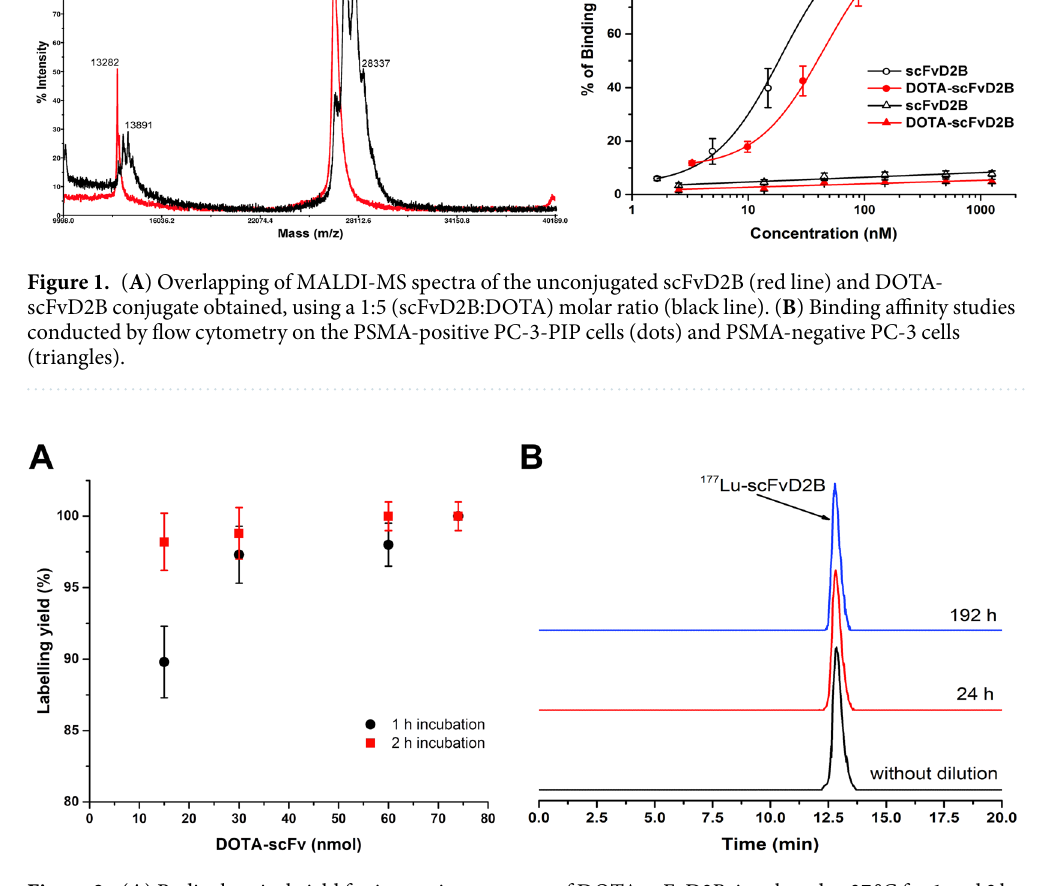
Figure 2. ( A ) Radiochemical yield for increasing amounts of DOTA-scFvD2B, incubated at 37 °C for 1 and 2 h. ( B ) Size-exclusion HPLC radiochromatograms of 177 Lu-scFvD2B obtained with a molar activity of 18 MBq/ nmol without dilution (black line) and after 24 and 192 h dilution in 0.1 M phosphate buffer at pH 7.0 (red and blue lines